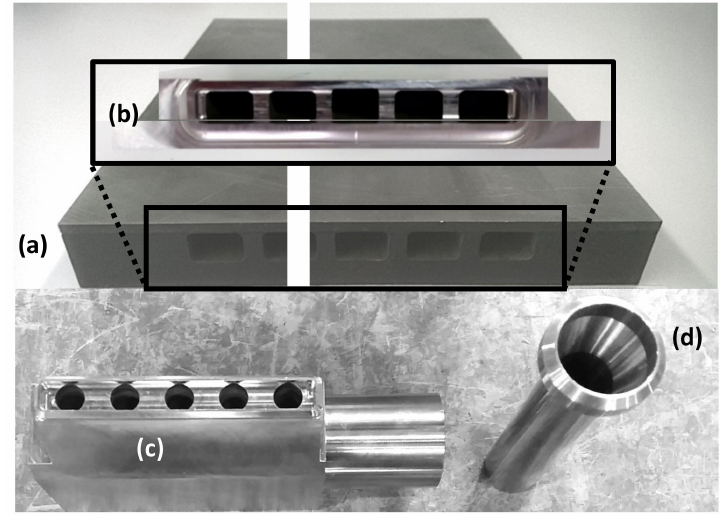
Figure 32. ( a ) The ODS plated mock-up block with the machined cooling channels; ( b ) connection milled in the mock-up plate on both ends of the cooling channels (indicated by lines); ( c ) connector part; ( d )